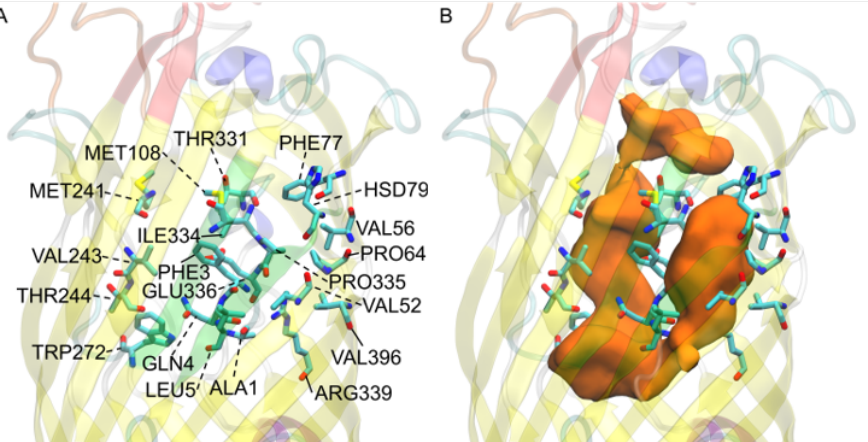
Figure 9. V. cholerae vc1042 FA interacting residues: ( A ) residue names and locations; ( B ) predicted transport channel shown from a surface view of all docked FAs (orange) shown with its relation to the displayed residues. The L3 loops is colored red, the L4 loop is colored orange, and the S3 kink is colored green for